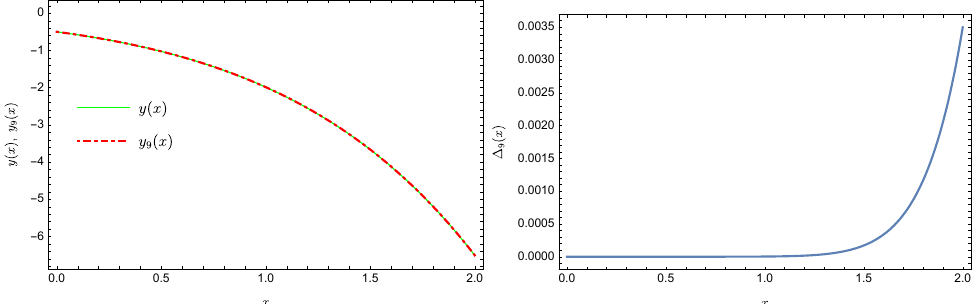
Figure 14. Exact solution and the approximate solution y 10 ( x ) together with the error ∆ of this